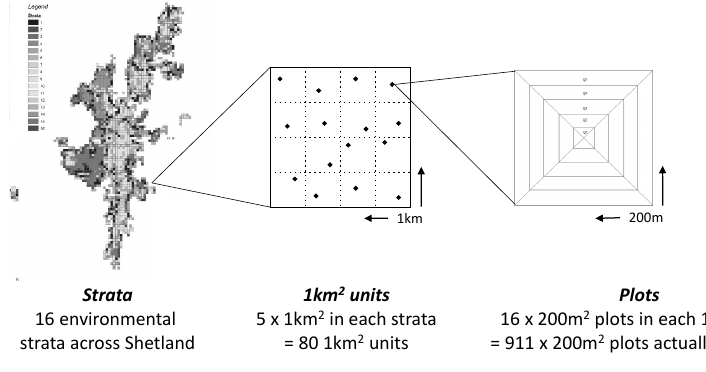
Figure 4. Sampling design.